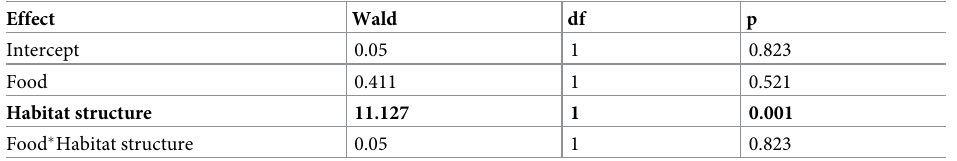
Table 5. The effect of predation by C . erythraea on Sympetrum spp. GLM (Distribution: Binomial; Link function: Logit) results for the effect of habitat structure, food supply, and the interaction of factors on number of Sympetrum individuals survived at the end of predation experiments. Significant effects are in bold.